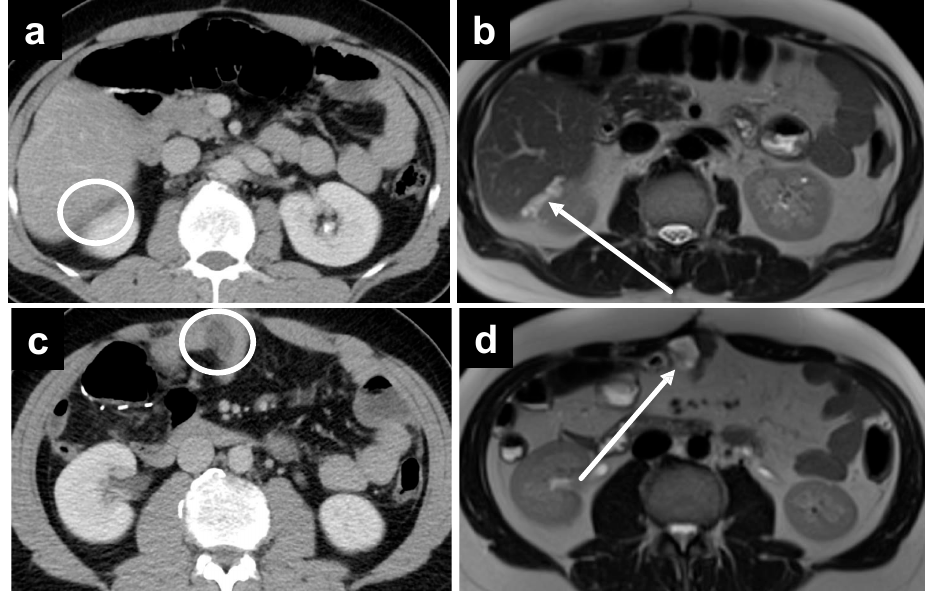
Figure 7. A 44-year-old male with recurrent mucinous appendiceal tumor; the hypodense fluid is not well seen on the ( a ) CT at Morrison’s pouch but easily seen on the ( b ) T2W MRI, where the fluid also appears to be loculated, suggestive of a tumor deposit as opposed to bland ascites. Similarly, the pocket of fluid among small bowel loops is not as well appreciated on ( c ) CT but is well seen on ( d ) T2W MRI.